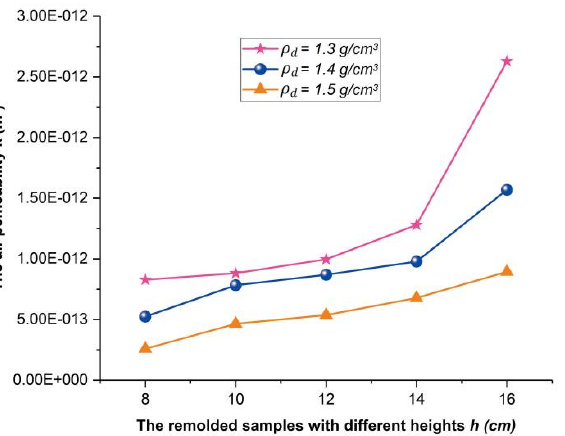
Figure 9. The variation in the air permeability coefficients of remolded samples with different heights.